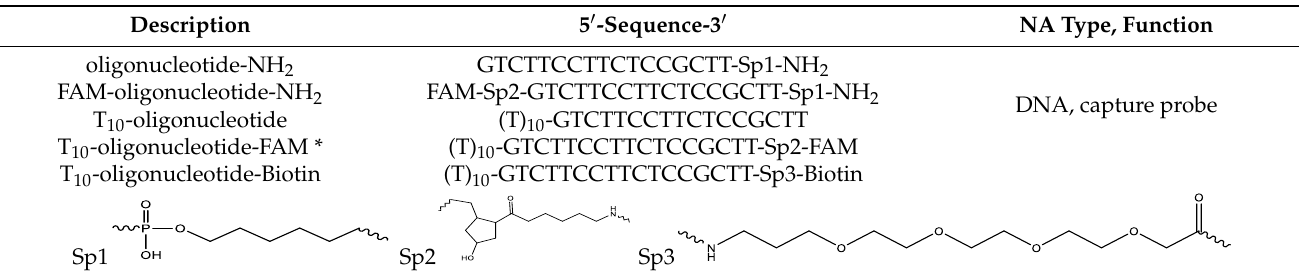
Figure 2. Two synthetic routes of oligonucleotide surface modification on MNPs ( A ) and MNP@Ny6 nanocomposites ( B ). TEOS―tetra ethyl orthosilicate, APTES — (3-aminopropyl) triethoxysilane, TCT — 2,4,6-trichloro-1,3,5-triazine. For the procedures, oligonucleotides with the amino group or T 10 oligothymidylate tract were used (for structures, see Table 1). Table 1. Oligonucleotide sequences.